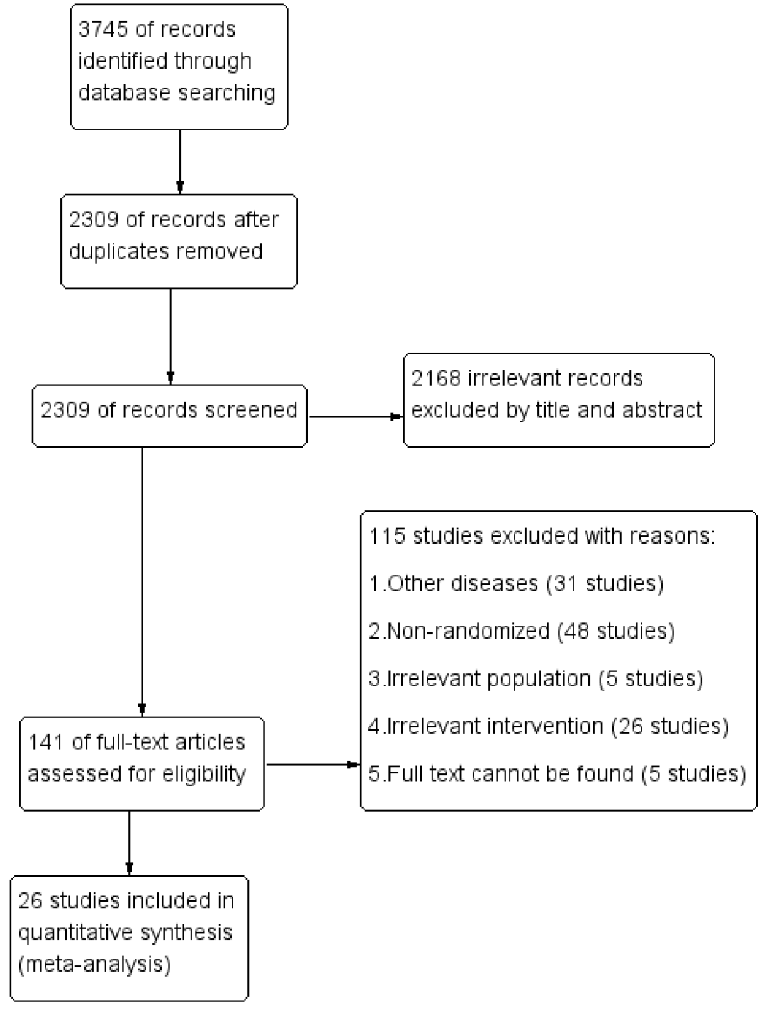
Figure 1. Prisma flowchart for the study selection process. Table 1. Characteristics of the included studies.